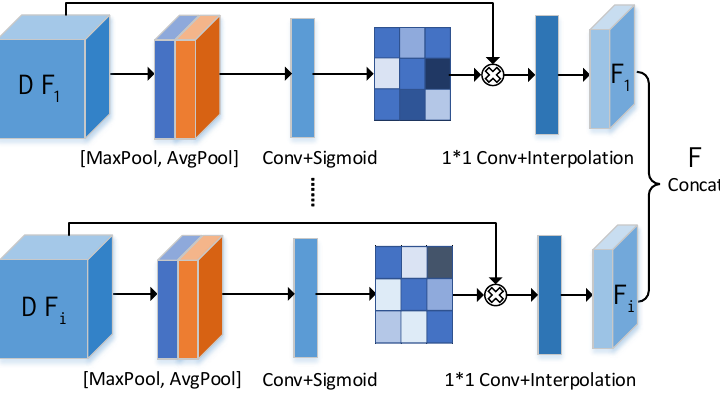
Figure 5. The details of the spatial context fusion